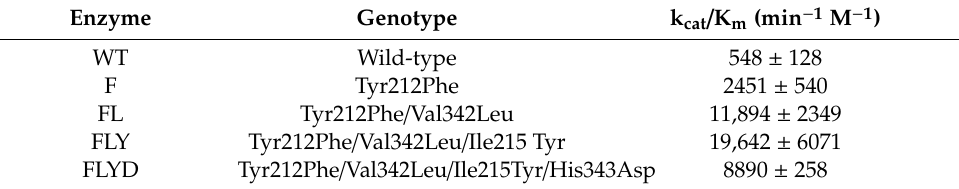
Table 6. Genotypes and kinetic parameters of OPAA enzymes